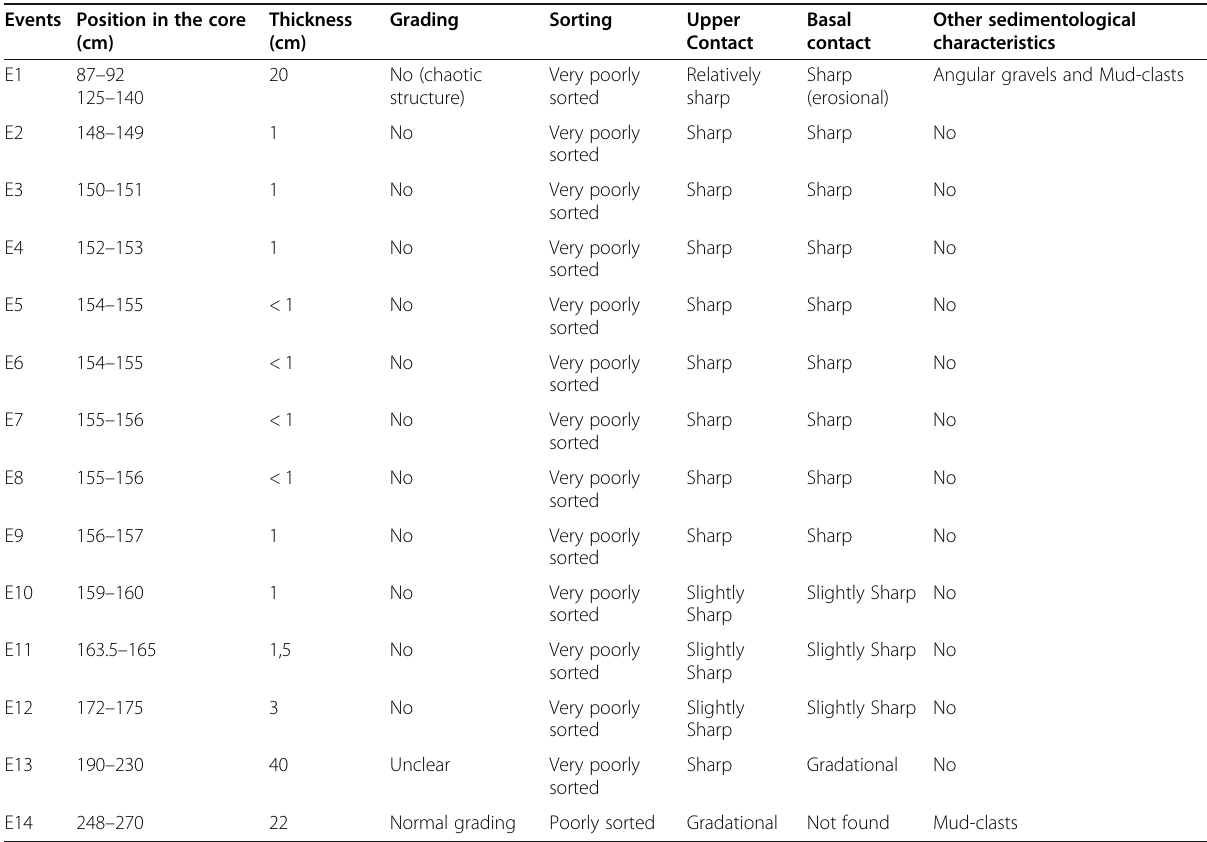
Table 3 Sedimentological characteristics of marine submersions deposits along the TAH17 – 1 core Events Position in the core Thickness Grading Sorting Upper (cm) (cm)